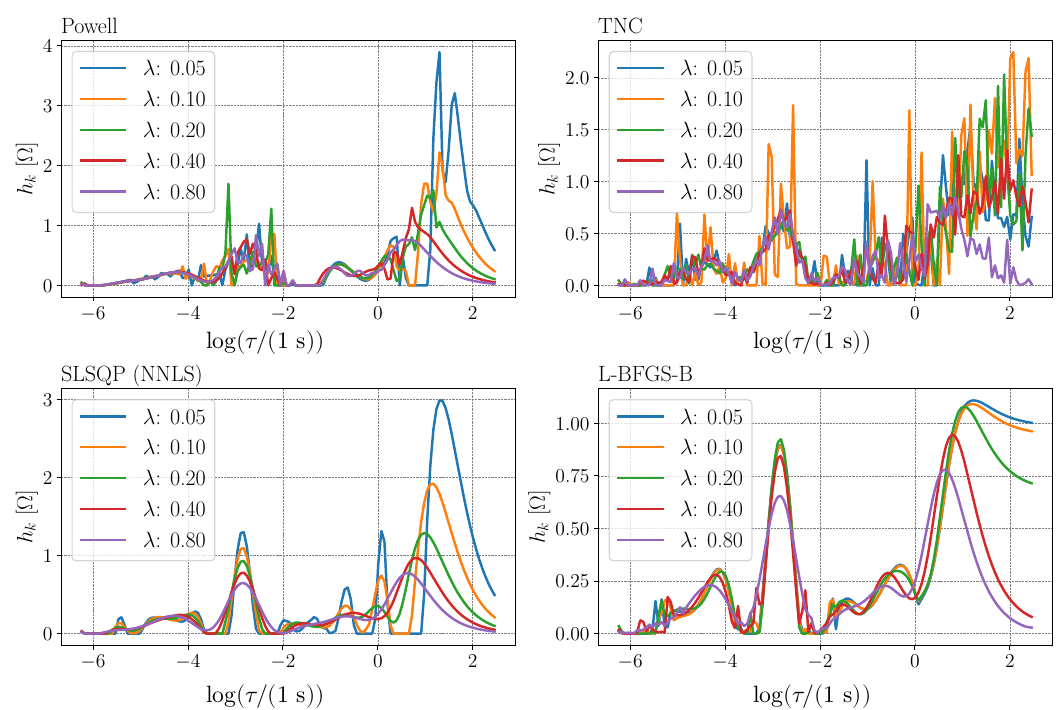
Figure 4. Comparison of different minimization algorithms: Powell, TNC, SLSQP, and L-BFGS-B. The SLSQP algorithm shows the same result as the NNLS algorithm. The regularization parameter λ influences the DRT (see Equation (12)) with increasing values and smooths the